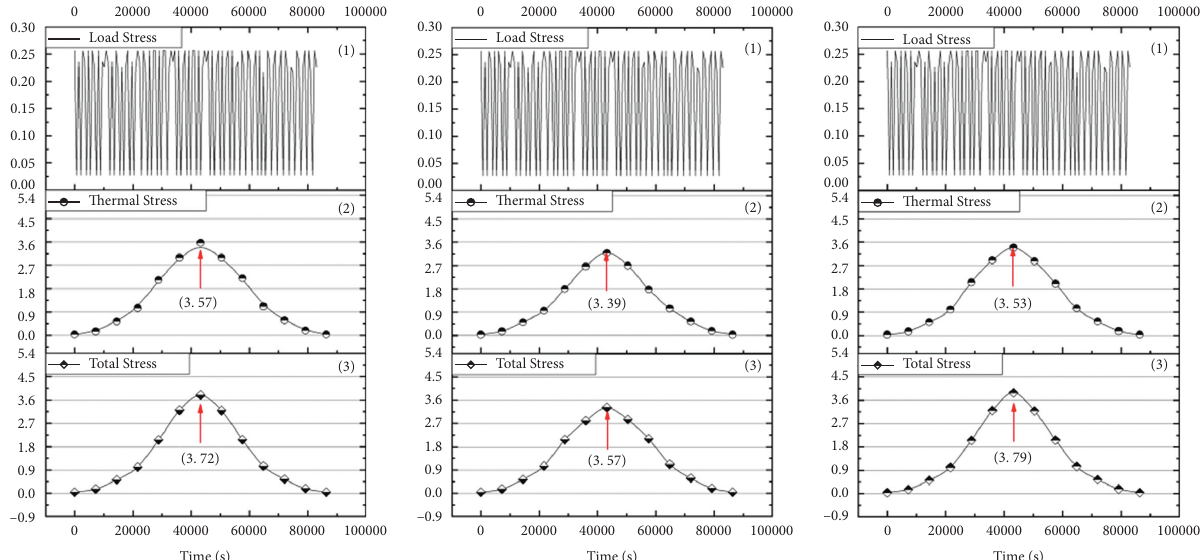
Figure 15: Maximum tensile stress (MPa) at slab corner under the coupling of thermal and traffic loads in winter: (a) “normal” condition, (b) “void” condition, and (c) “polymer”